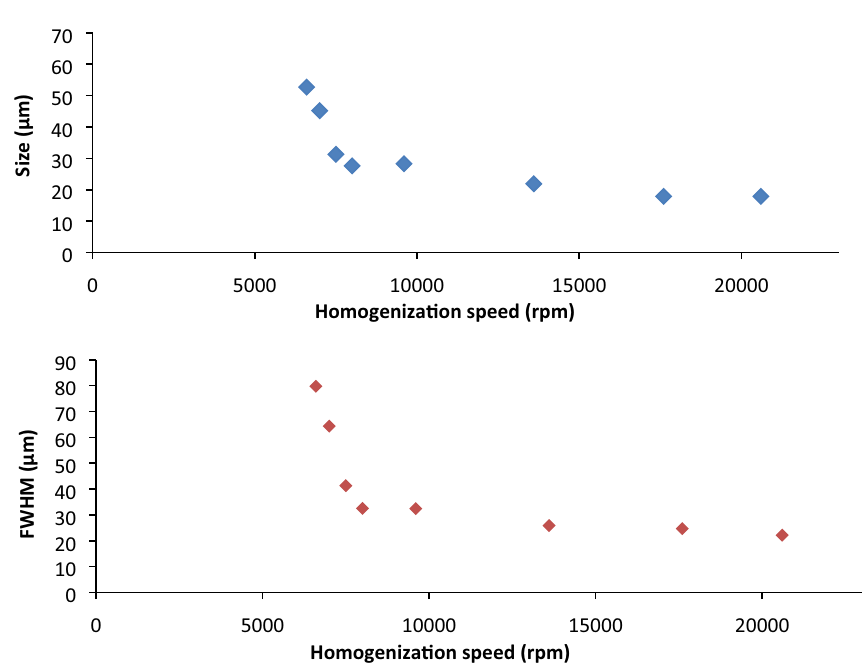
Figure 3. ( A ) Effect of homogenization speed on the size of PCL microparticles (with 1% PVA). ( B ) Full width half maximum (FWHM) of different PCL microparticles as a function of homogenization